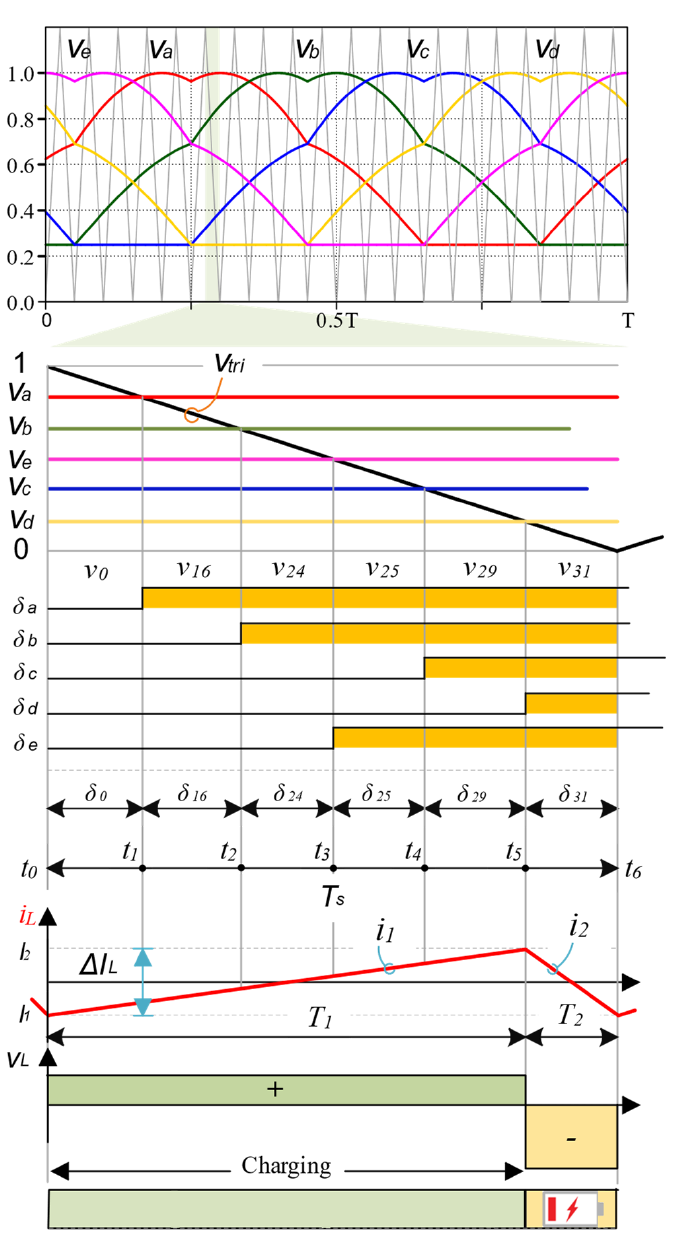
Figure 10. Duty cycles of the modulating signals of 5-phase SSI for M = 0.75 for one complete period and inductor current and voltage waveforms for sector 1.